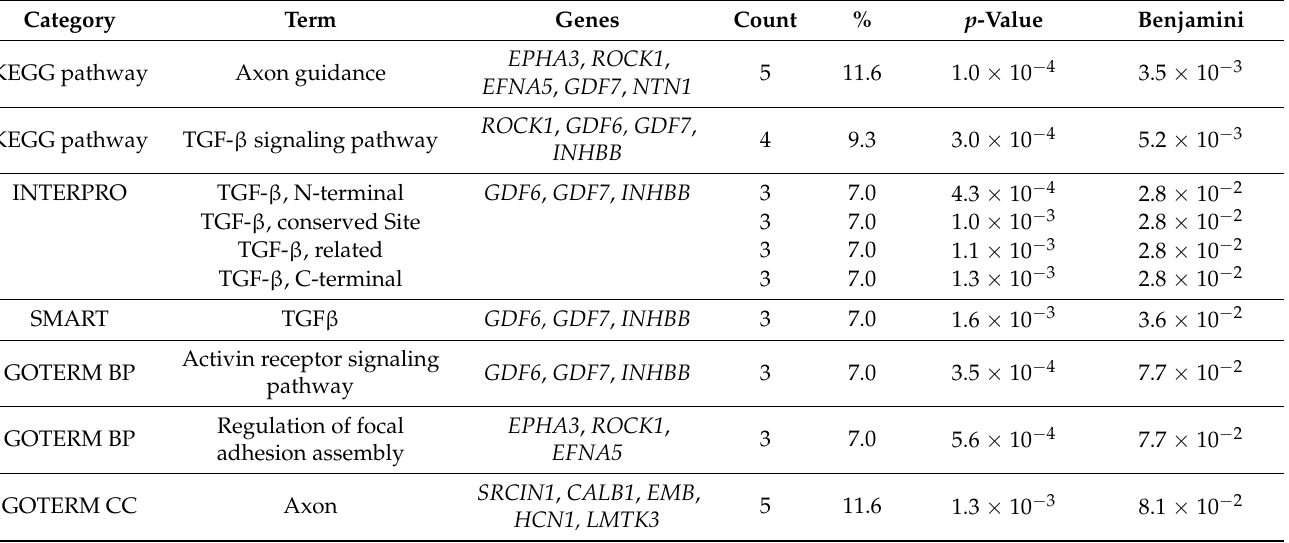
Table 1 A simplified table of the top 10 pathways identified through DAVID functional annotation for the H3K27me3 gene list. From these results, axon guidance was identified as the most significantly enriched pathway with a p -value of 0.00010 (1.0 × 10 − 4 ) and a Benjamini value of 0.0035 (3.5 × 10 − 3 ). Furthermore, the activin signaling pathway was identified as significant with p -value of 0.00034 (3.5 × 10 − 4 ) and a Benjamini value